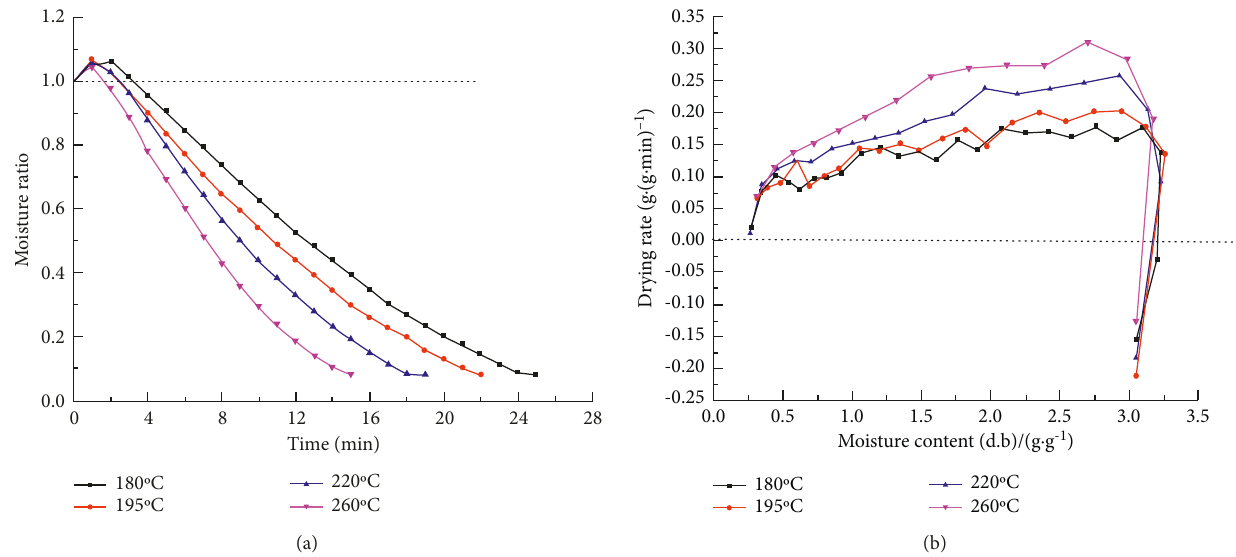
Figure 2: Drying curves and drying rate curves of 6mm sludge at different steam temperature under steam flow of 22 m 3 /h. (a) Drying curves. (b) Drying rate curves.